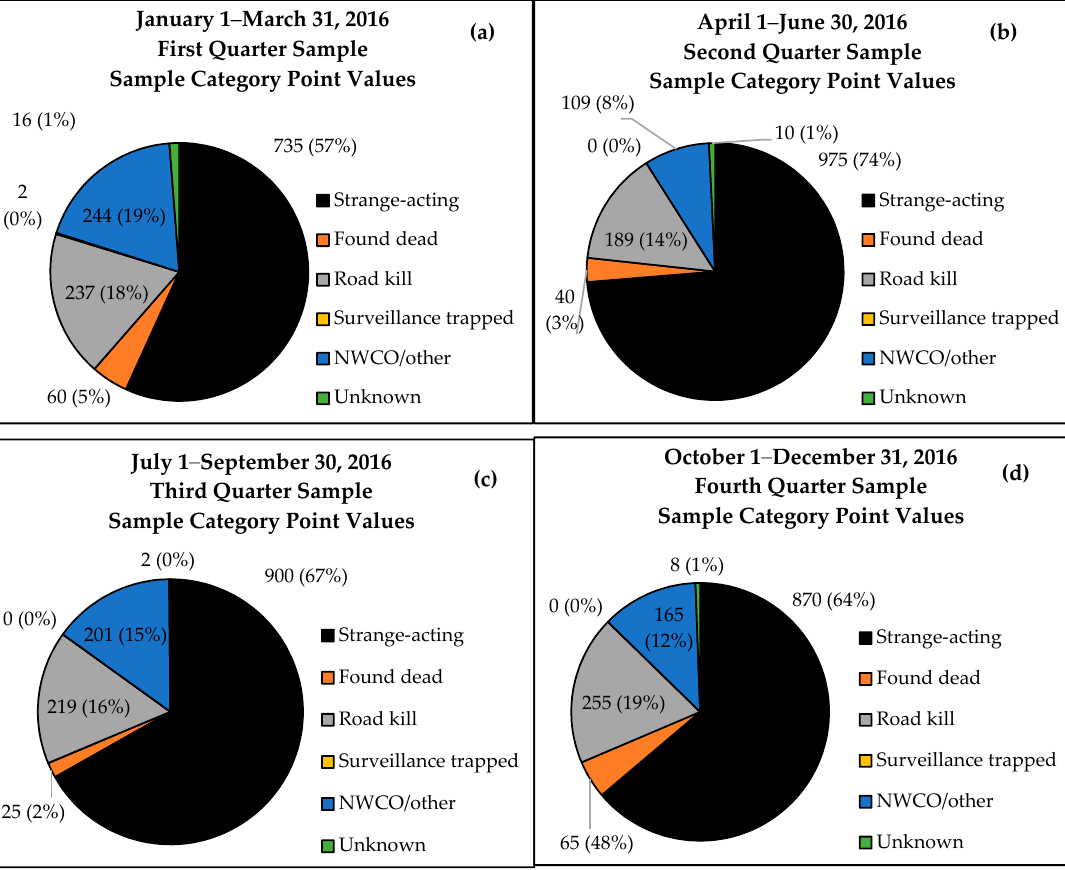
Figure 2a – d. Minimum threshold weighted points and percentages by sample category for 16 states during ( a ) Quarter 1; ( b ) Quarter 2; ( c ) Quarter 3; and ( d ) Quarter 4 in 2016.